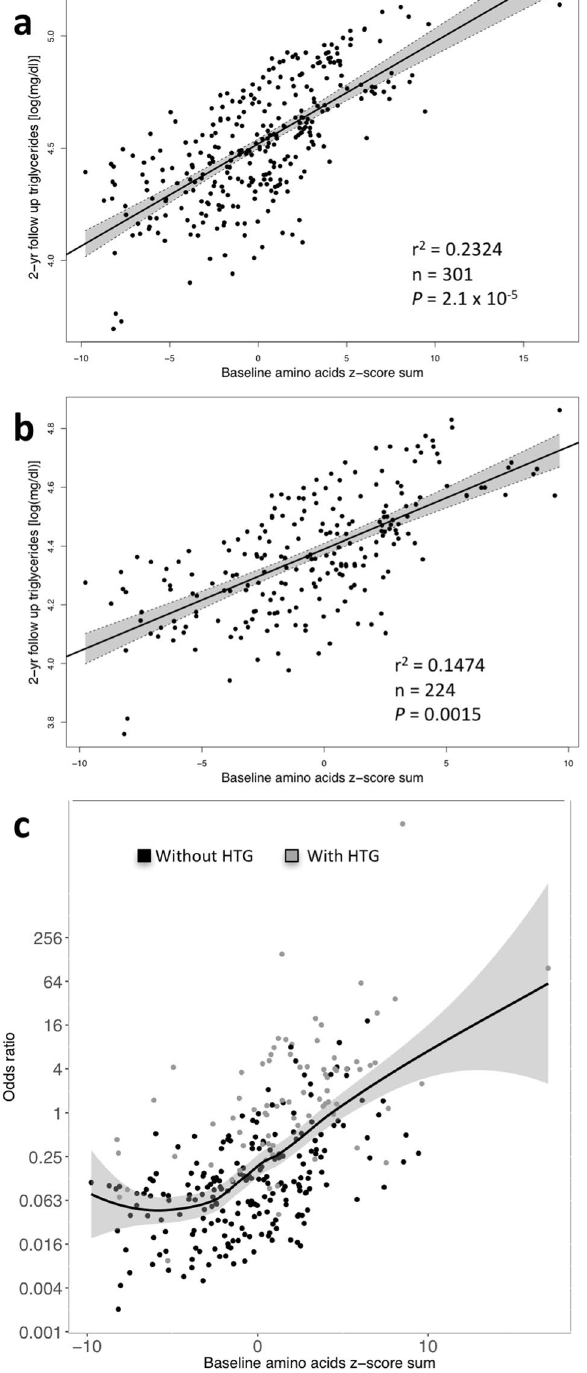
Figure 2. Longitudinal study. Association between z-score sum of baseline amino acids from PC2-Z (arginine, leucine/isoleucine, phenylalanine, tyrosine, valine and proline) and triglycerides after 2 years. ( a ) All individuals. ( b ) Individuals without hypertriglyceridemia (HTG) at baseline. ( c ) Logistic regression model reflecting risk of HTG (with 95% CI) according to PC2-Z and excluding children with HTG at baseline (n = 224). The multivariate model was adjusted by gender, and sampling calendar year as well as baseline age, BMI percentile and serum